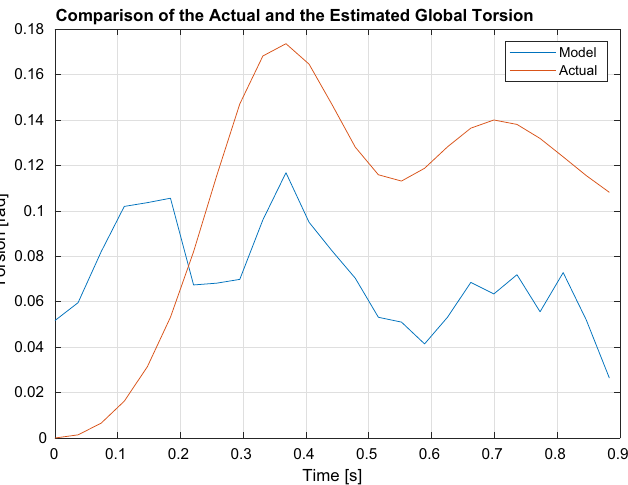
Location of POIs LV Epi LV Endo RV Mean RMSE (Std. Dev) [mm] Table 7. The summary of the results for the varying slice plane experiments. The averages and standard deviations of the RMS tracking errors across the eight Cine MR datasets are presented.